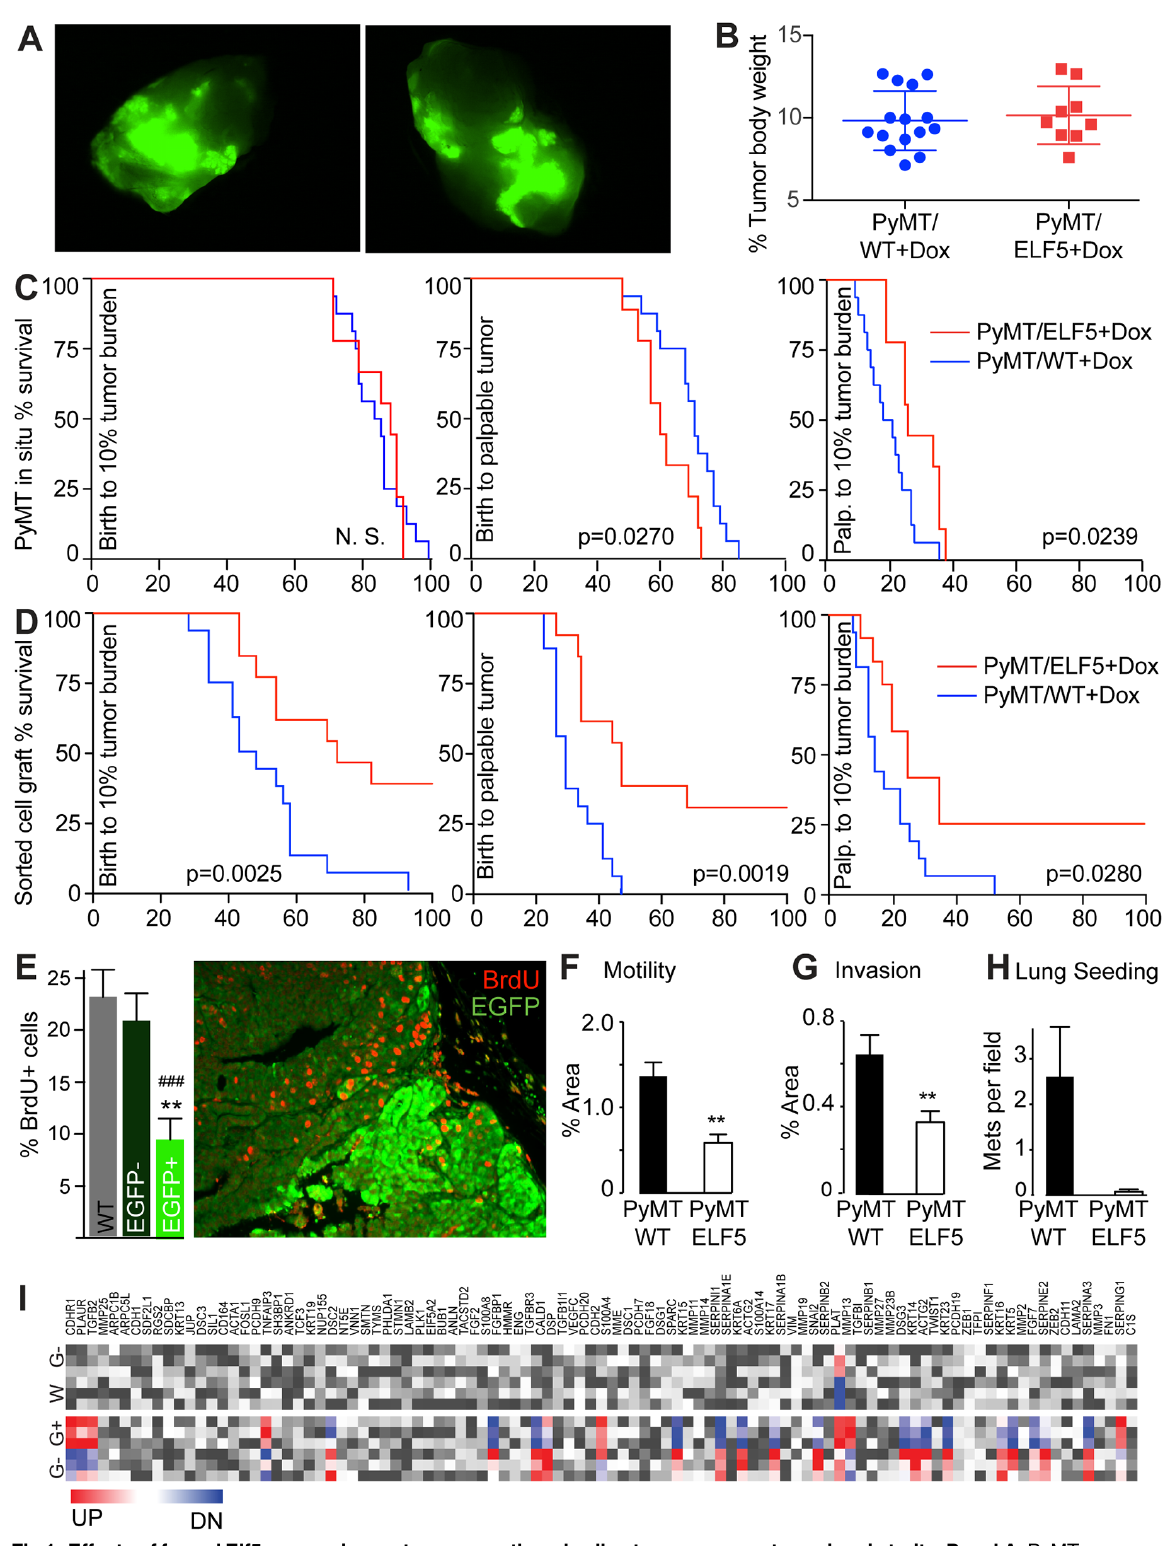
Fig 1. Effects of forced Elf5 expression on tumor growth and cell autonomous pro-tumorigenic traits. Panel A , PyMT mammary tumors showing heterogeneous expression of ELF5 visualized by EGFP expression. Panel B , percent primary tumor burden for each experimental group